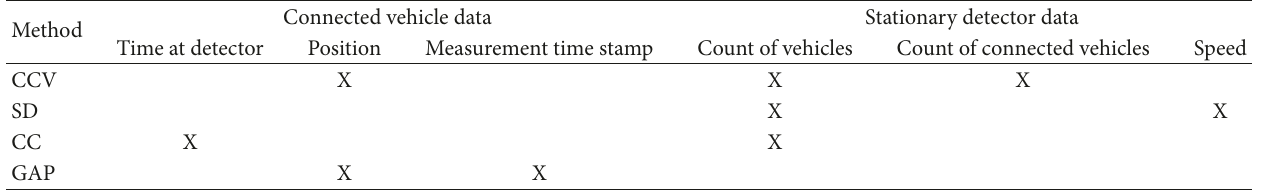
Table 1: Required measurements for estimating density based on CCV method, SD method, CC method, and GAP